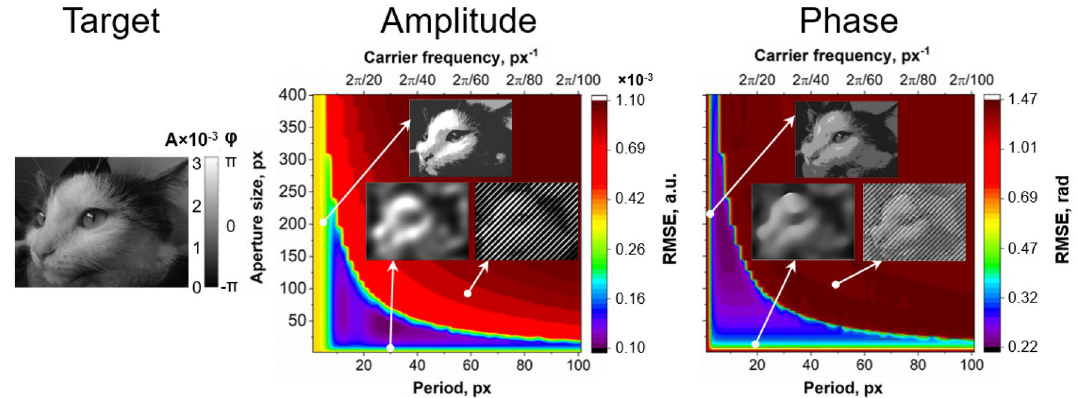
Figure 3. Amplitude and phase modulation RMSE maps dependent on aperture size and fringe period for the “cat” object. Insets: obtained intensity and phase distributions at the points indicated by the markers. Target distribution is shown on the